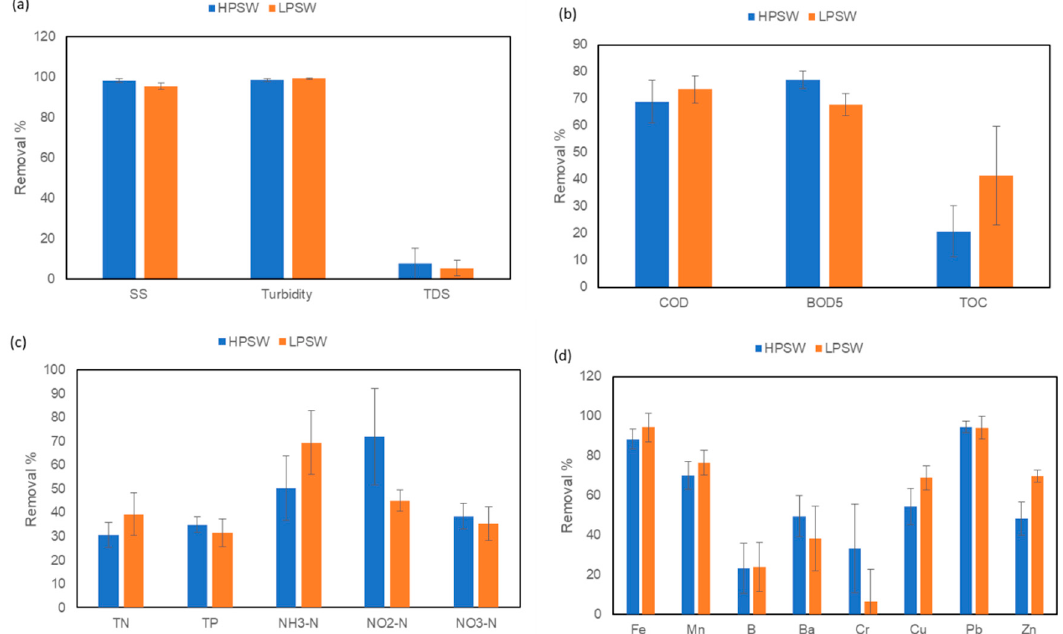
Figure 9. Removal efficiencies of ( a ) SS, turbidity and TDS, ( b ) organics, ( c ) nutrients, and ( d ) heavy metals from HPSW and LPSW after infiltration through permeable clay bricks. Table 4. SWs quality of two processes and standard limit for recycling and drinking water.